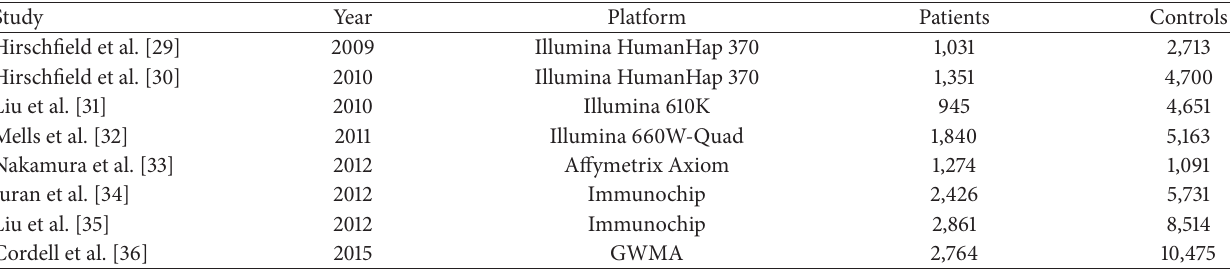
Table 2: GWAS on PBC.